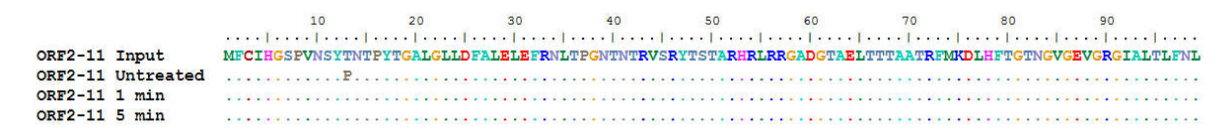
Frontiers in Microbiology |